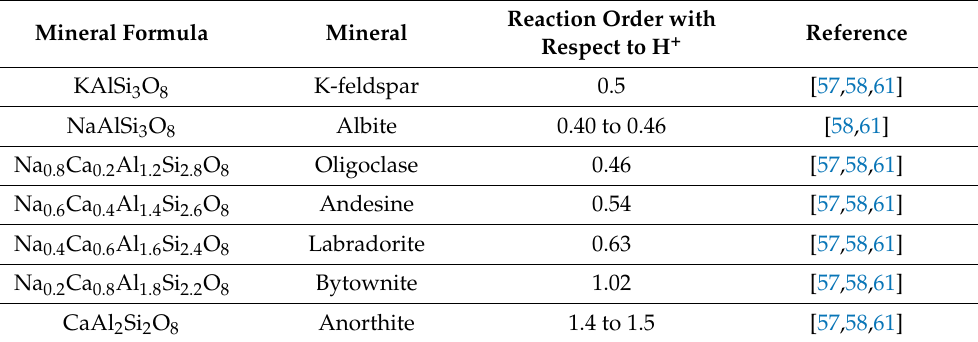
Table 4. Orders of reaction with respect to H + , H 2 S and M 2+ for the dissolution of metal sulphides.